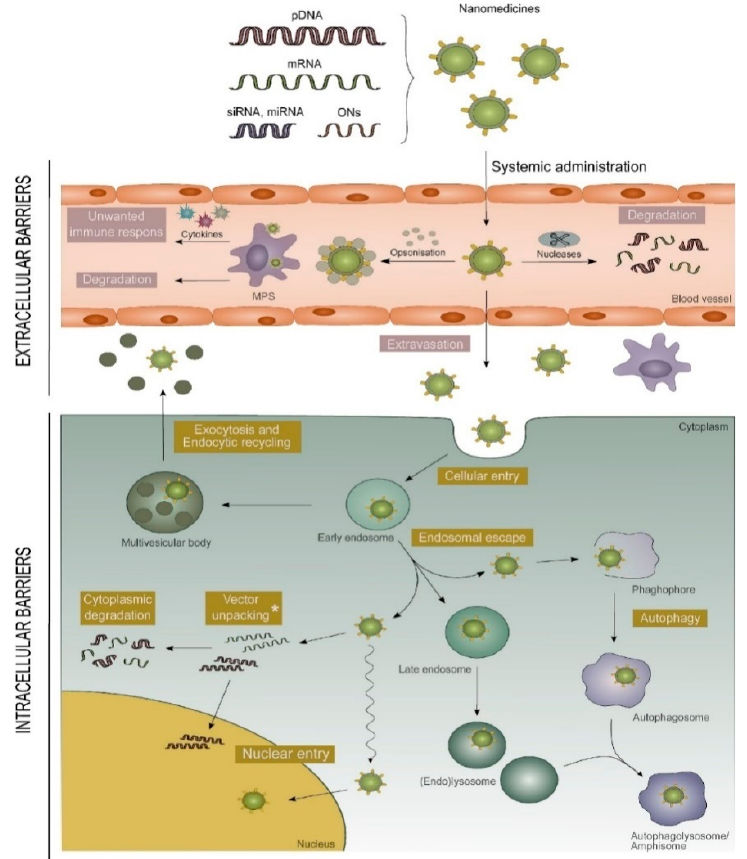
Figure 1. Biological barriers to overcome when using nonviral vectors to deliver nucleic acids in vivo. Nucleic acids bind to peptides through electrostatic interactions, transferring them across the cell membrane via endocytosis, providing endosome escape, and ultimately releasing the associated nucleic acids in the cytoplasm or nucleus. Reprinted with permission from Ref. [20]. Copyright 2018, Elsevier.